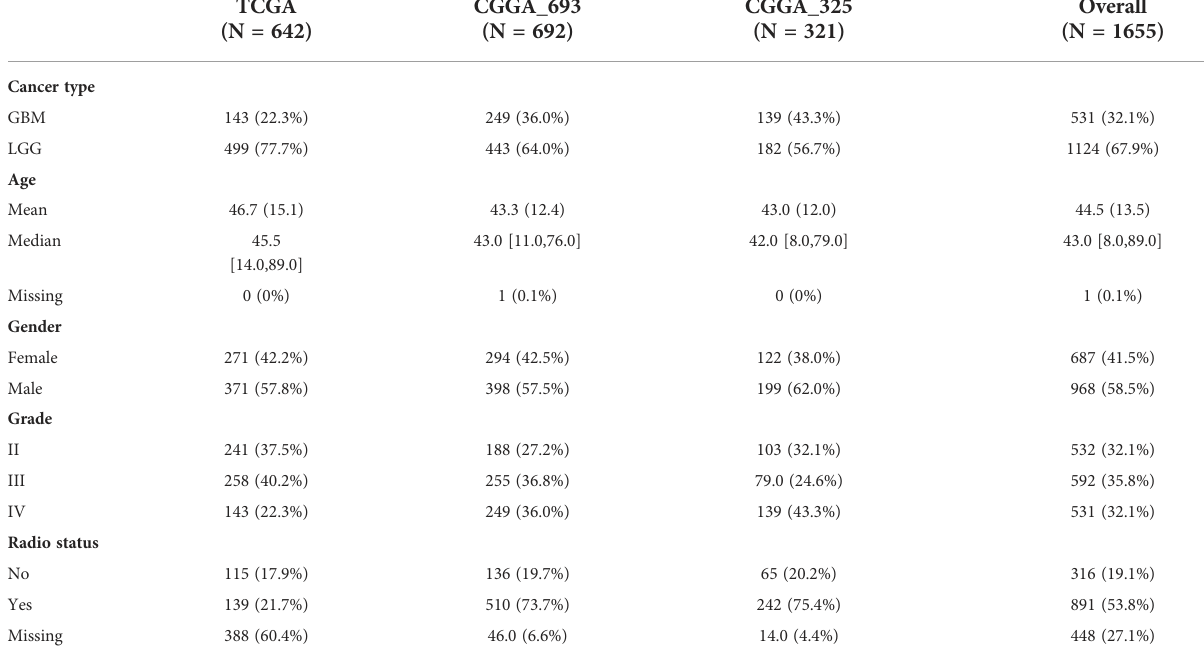
TABLE 1 Patients ’ clinical features from the bulk